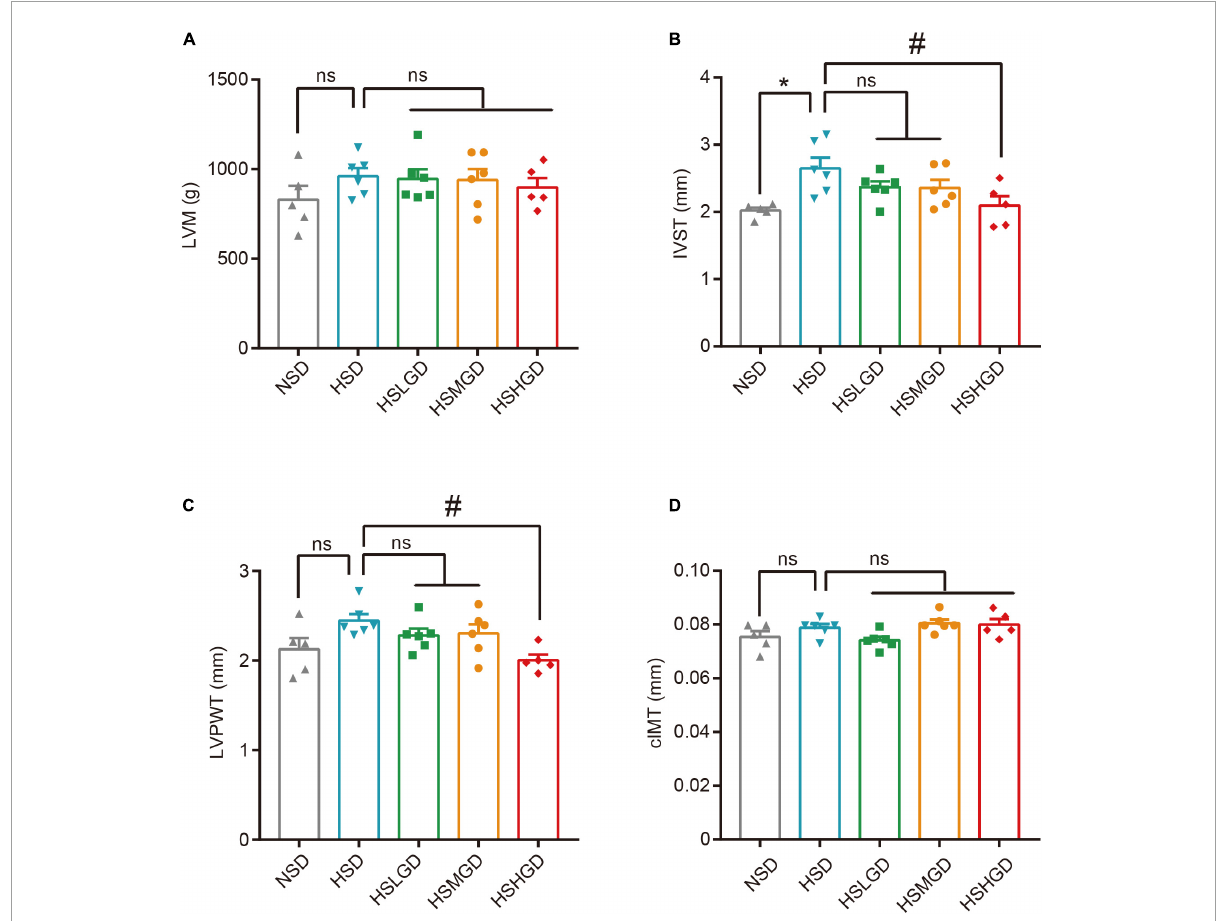
FIGURE3 Effects of dietary glutamine on the carotid artery and heart in salt-induced hypertensive rats. (A–D) Rats were fed on a normal-salt diet (NSD), high-salt diet (HSD), high-salt + low-dose glutamine diet (HSLGD), high-salt + middle-dose glutamine diet (HSMGD), or high-salt + high-dose glutamine diet (HSHGD) for the 7-week rearing experiment. Data exhibit the indicated ultrasound parameters including LVM (A) , IVST (B) , LVPWT (C) , and cIMT (D) measured at 7 weeks. n = 5 (NSD, HSHGD) or 6 (HSD, HSLGD, HSMGD) rats per group. Data are presented as means ± SEM. * P < 0.05 compared with NSD group; # P < 0.05 compared with HSD group. ns, no significance. One-way ANOVA followed by Bonferroni’s post-hoc test (A–D) . LVM, left ventricular mass; IVST, interventricular septal thickness; LVPWT, left ventricular posterior wall thickness; cIMT, carotid intima-media